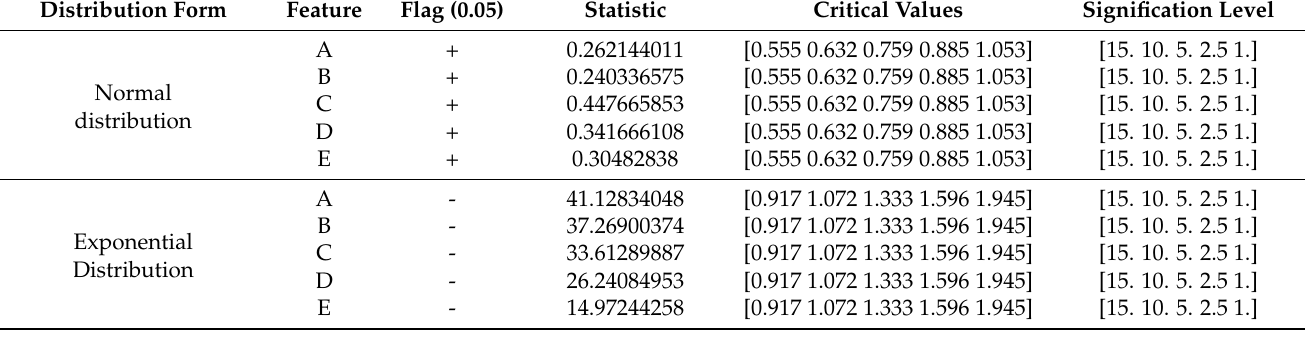
Table 10. Distribution pattern test results based on Anderson–Darling test.